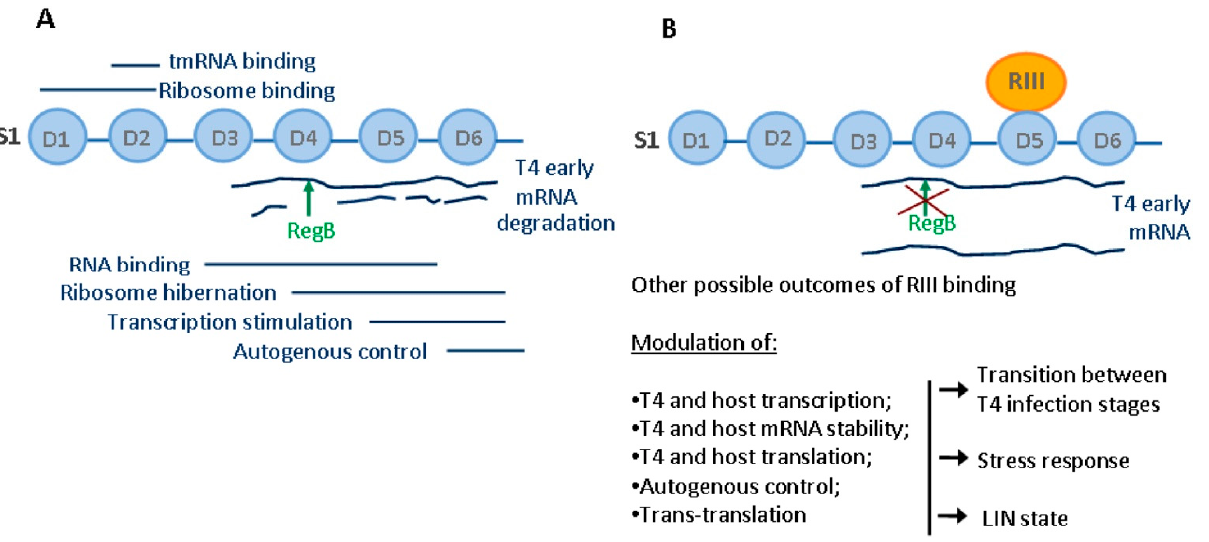
Figure 5. Functions of the ribosomal protein S1 in E. coli and possible outcomes of RIII–S1 interaction. ( A ) Known functions of S1 domains in E. coli . ( B ) Possible outcomes of RIII binding to S1 during T4 infection.